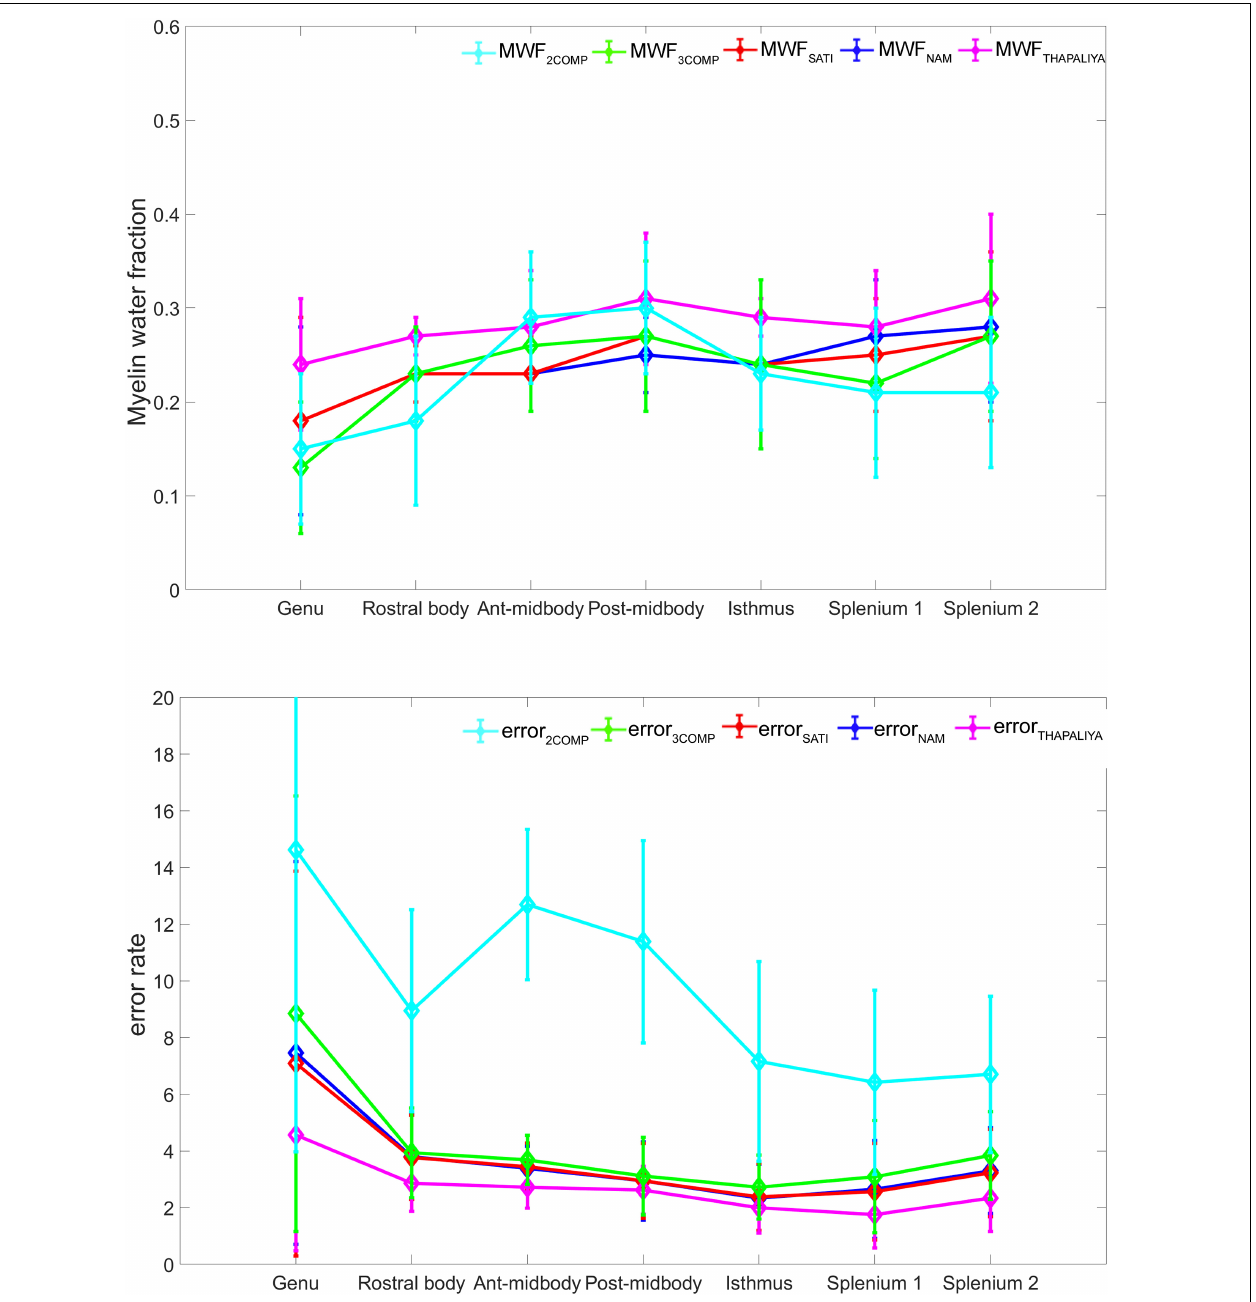
FIGURE 2 | Myelin water fraction (MWF) results for corpus callosum regions of interest (ROIs) (top) and model fitting error for the different models (bottom) . The mean and standard deviations across participants are provided.